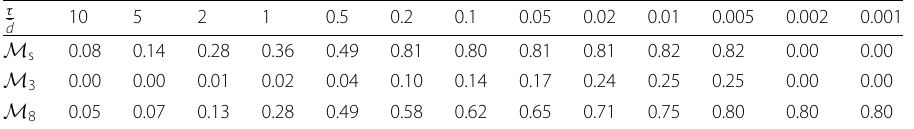
Table 2 ARI scores for regularized traditional and motif-based spectral clustering on the US-P OLITICAL -B LOGS network τ